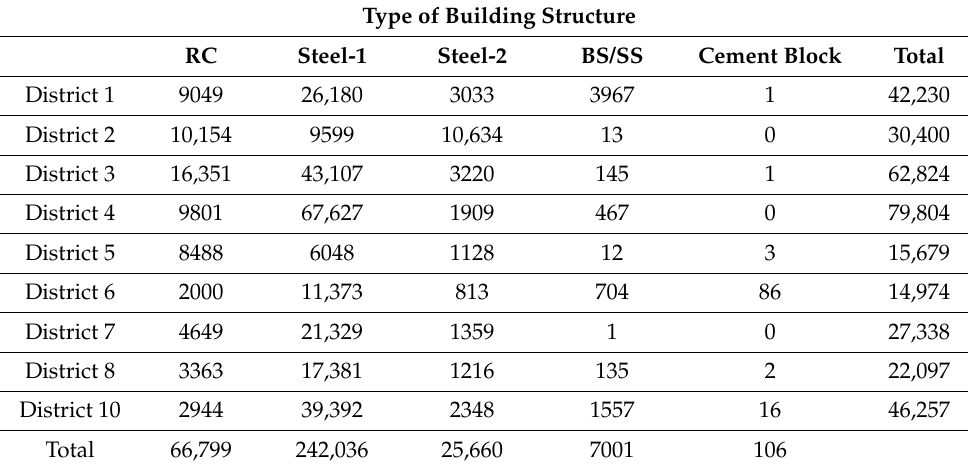
Table 5. Building classes and the numbers of buildings.